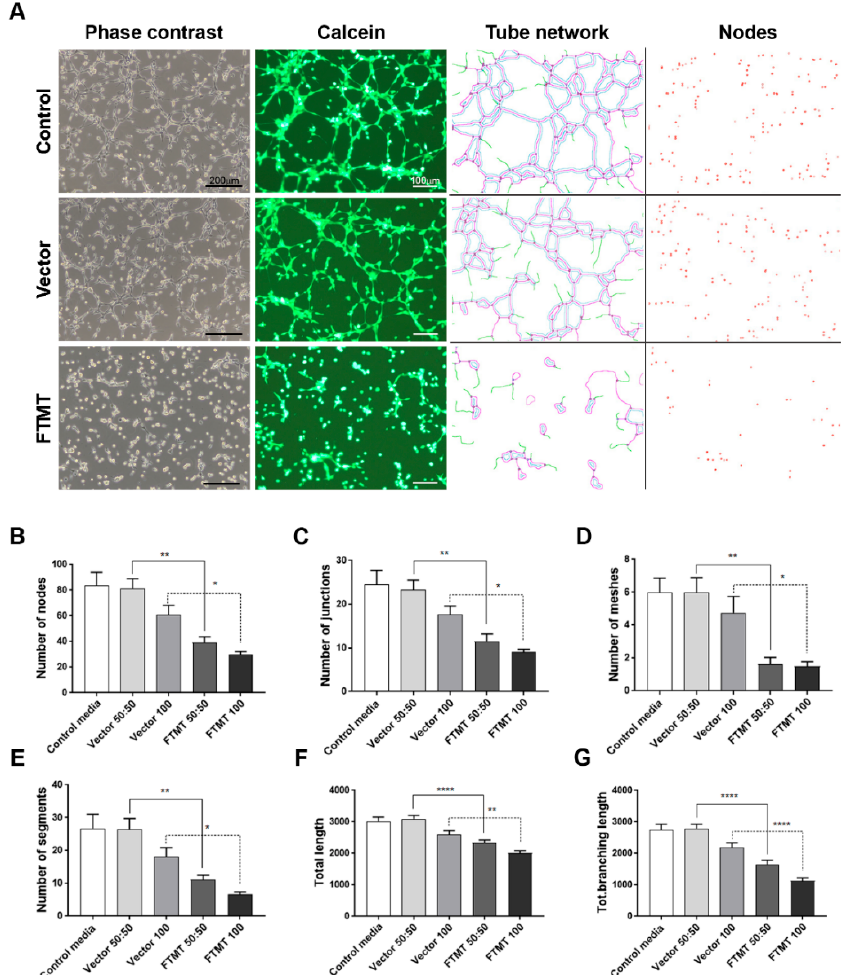
Figure 7. Conditioned media from undifferentiated FTMT-overexpressing ARPE-19 cells inhibit in vitro angiogenesis. ( A ) Representative phase contrast micrographs and calcein-AM fluorescent images of hCMEM/3D endothelial cell tube formation after 6 h in indicated condition media samples: Examples of ImageJ processed images for quantification of tube networks and nodes. Scale bars on phase contrast images represent 200 μ m and, on Calcein images, represent 100 μ m. ( B–G ) Bar charts showing effects at 6 h on hCMEM/3D tube formation parameters of control media, undiluted (vector 100) and diluted (vector 50:50) vector transfected cell conditioned media, and undiluted (FTMT 100) and diluted (FTMT 50:50) FTMT transfected cell conditioned media. ( B ) Number of tube nodes, ( C ) number of tube junctions, ( D ) number of tube meshes, ( E ) number of tube segments, ( F ) total tube length, and ( G ) total tube branching length. Results represent mean + S.E.M. of 2 replicate experiments with 4 measurements per treatment ( n = 8). Data were analyzed by one-way ANOVA with Sidak’s test (* p < 0.05; ** p < 0.01, and **** p < 0.0001, n = 8).